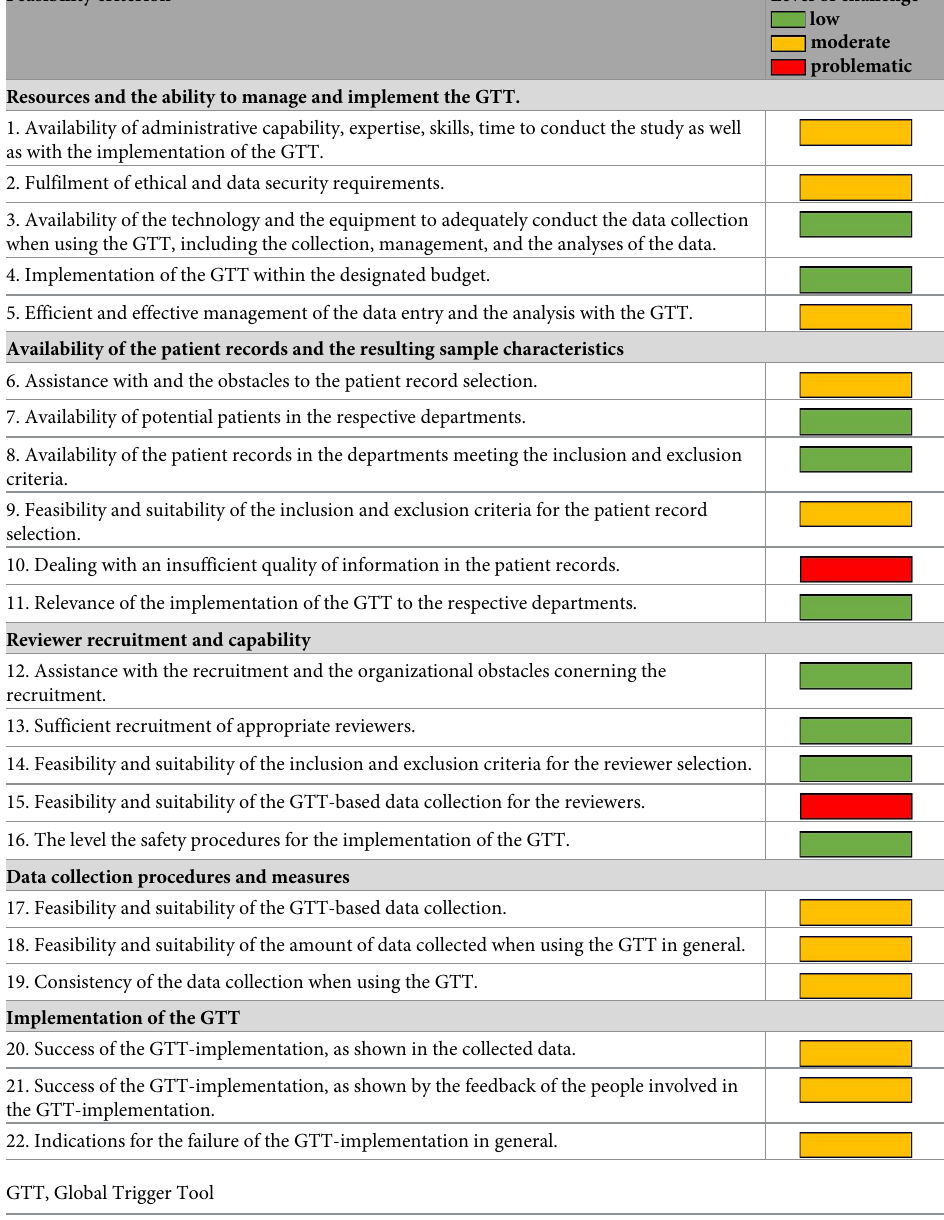
Table 3. The level of challenge is identified by the feasibility criteria for the implementation of the GTT. Feasibility